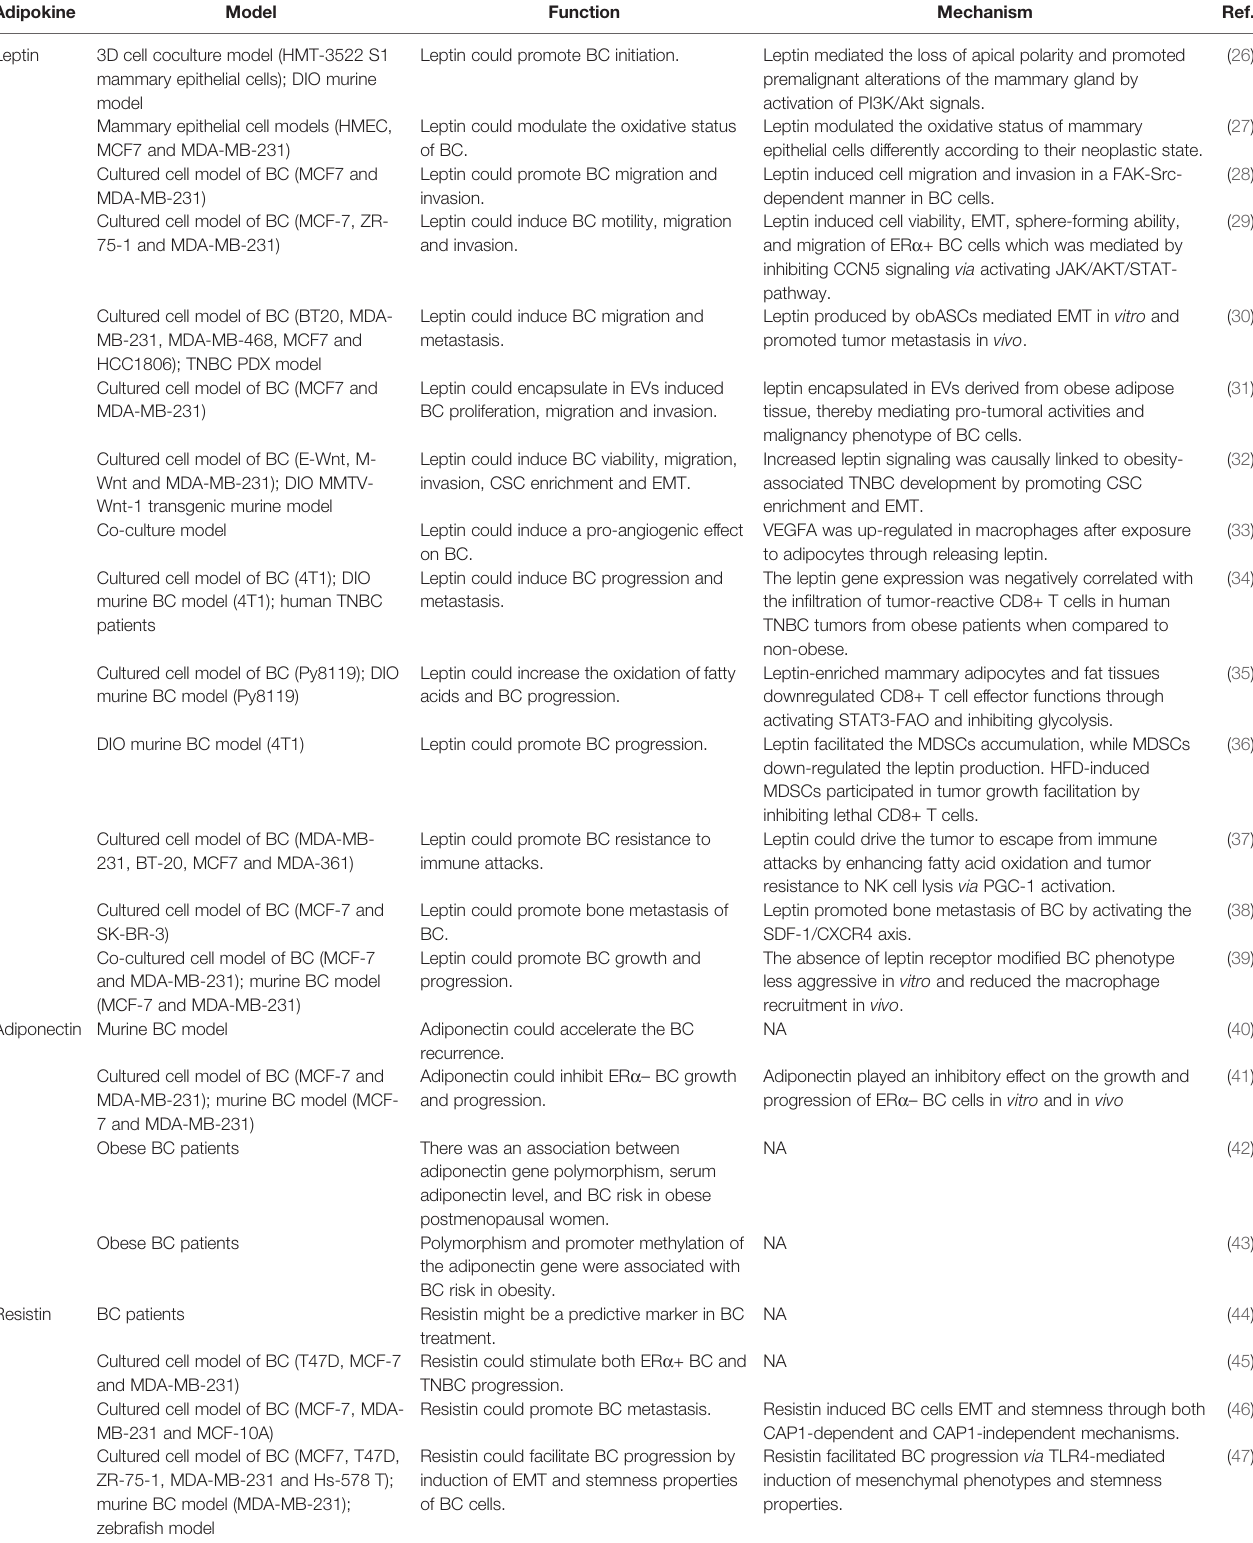
TABLE 1 | The roles of adipokines in linking obesity and BC. Adipokine Model Function Mechanism